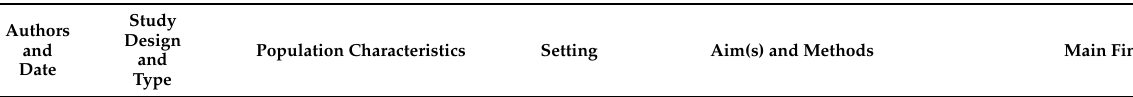
Table 4. Summary of study characteristics and main findings of included